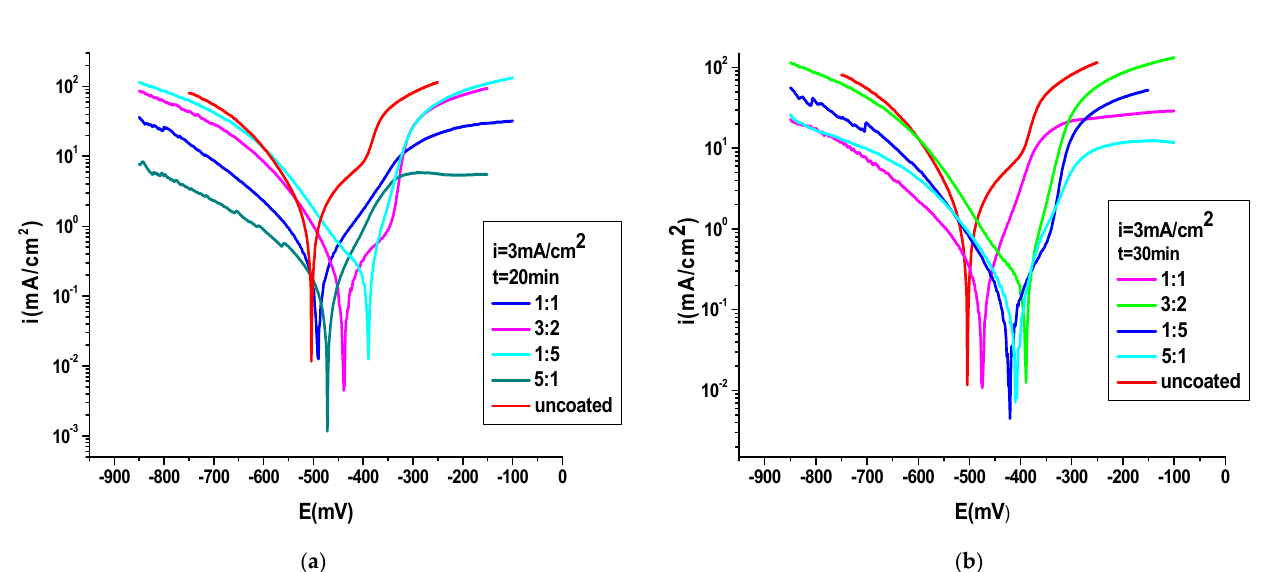
Figure 5. Polarization curves PNMPY-TRX100/PNNDEA ( a ) coated and ( b ) uncoated of OL 37 electrode in 0.5 M H 2 SO 4 by electrodeposition at 3 mA/cm 2 current density in different molar ratios where the deposition was admitted for 20 and 30 min.